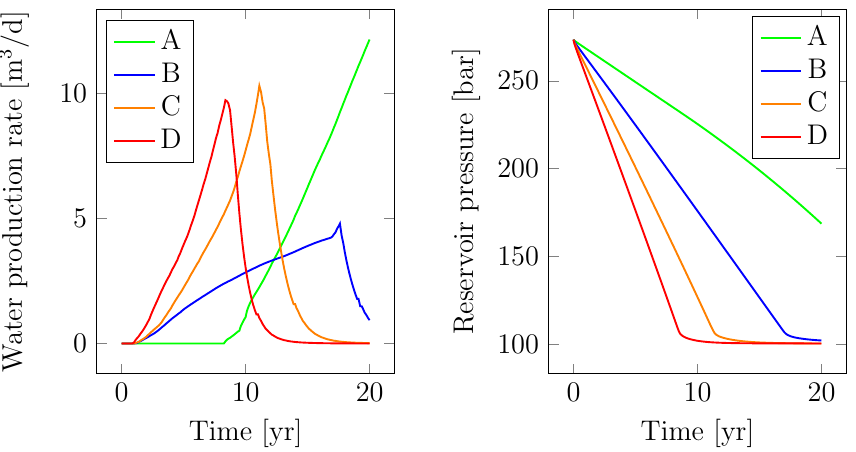
Fig. 16: Reservoir performance parameters, base on GA optimization run. Figure 16. Reservoir performance parameters, based on the GA optimization